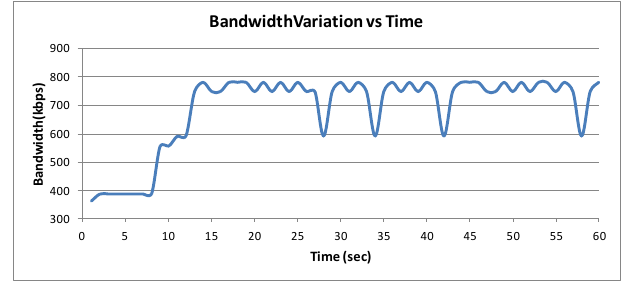
Figure 3. Bandwidth obtained with the HMM-BE